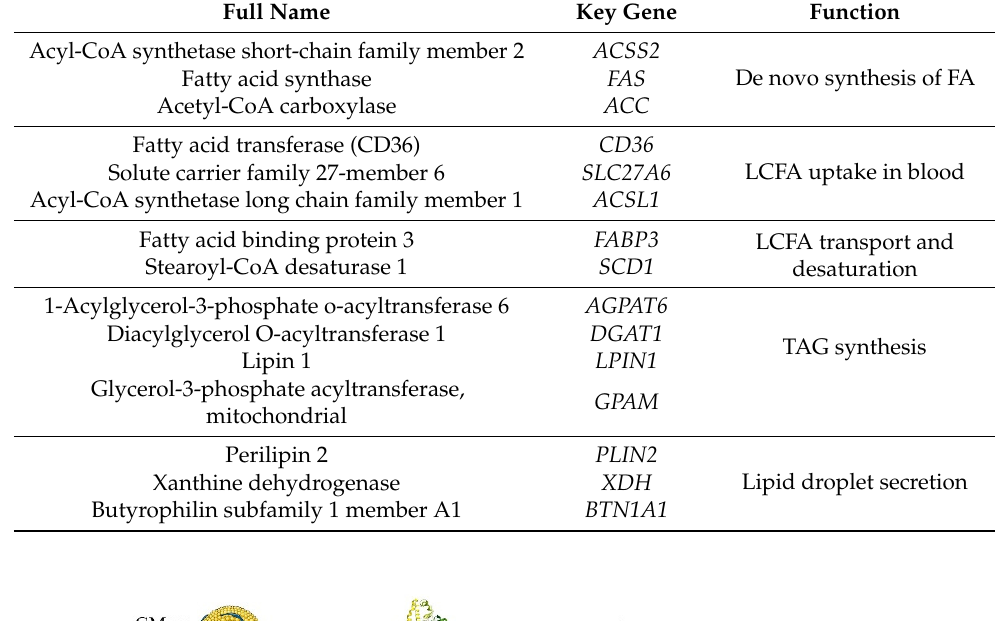
Table 1. Key genes involved in milk fat synthesis in ruminants [17].